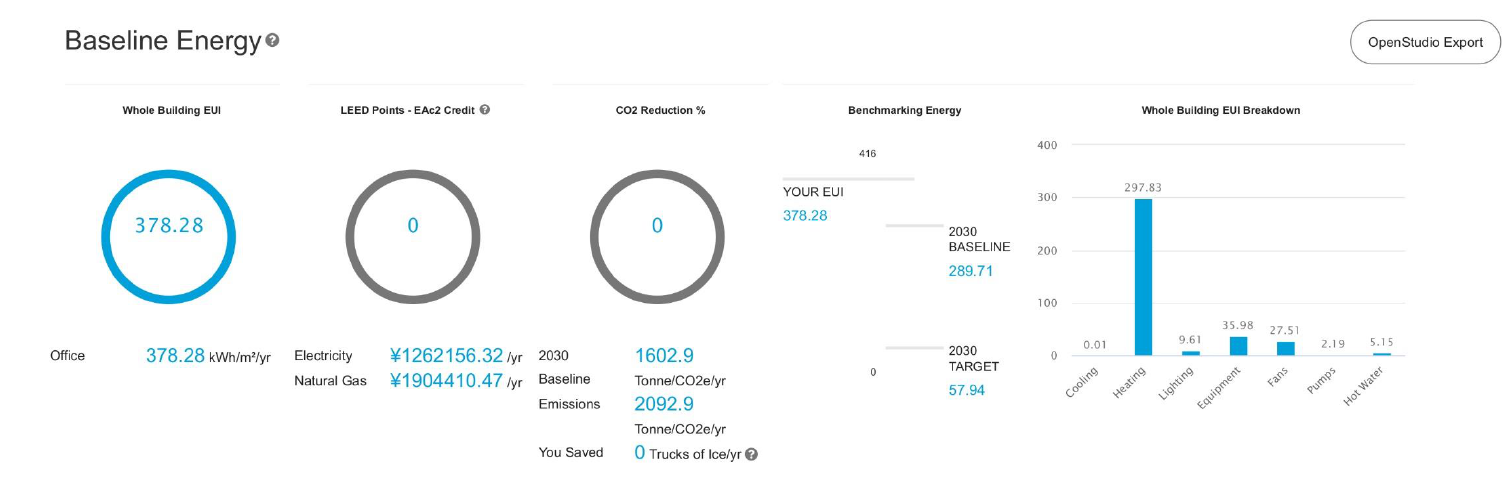
Figure A20. Zone 4-H Chamdo, Xizang (post-COVID-19 78% scenario).